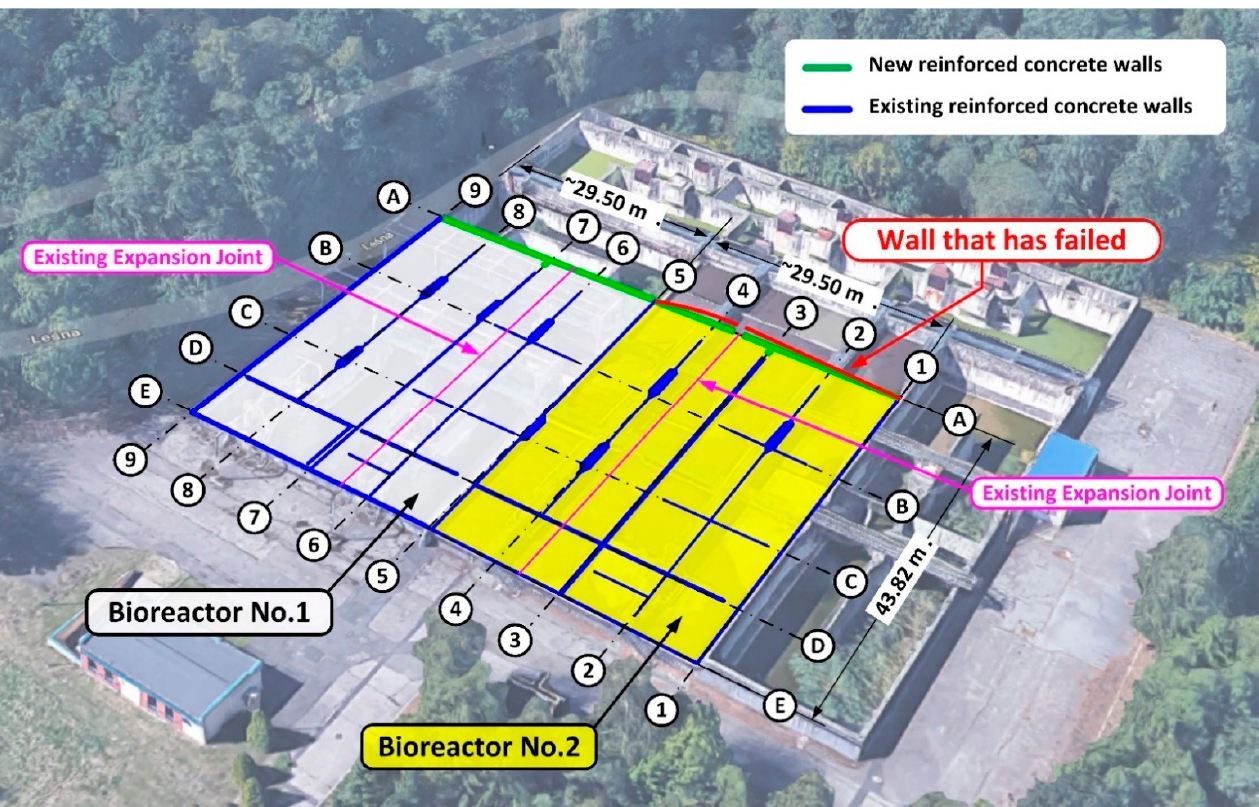
Figure 2. Scheme of renovation of the existing biological reactor. In the figure, the wall which failed during the leak testing is denoted on the A/1–5 axis, [m], (Google Map).